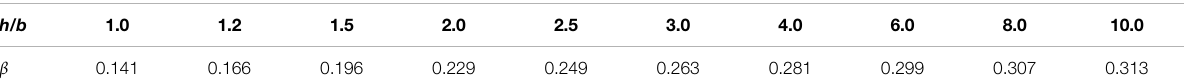
TABLE 2 | Torsional coef fi cient β of rectangular section component (Liu, 1985).